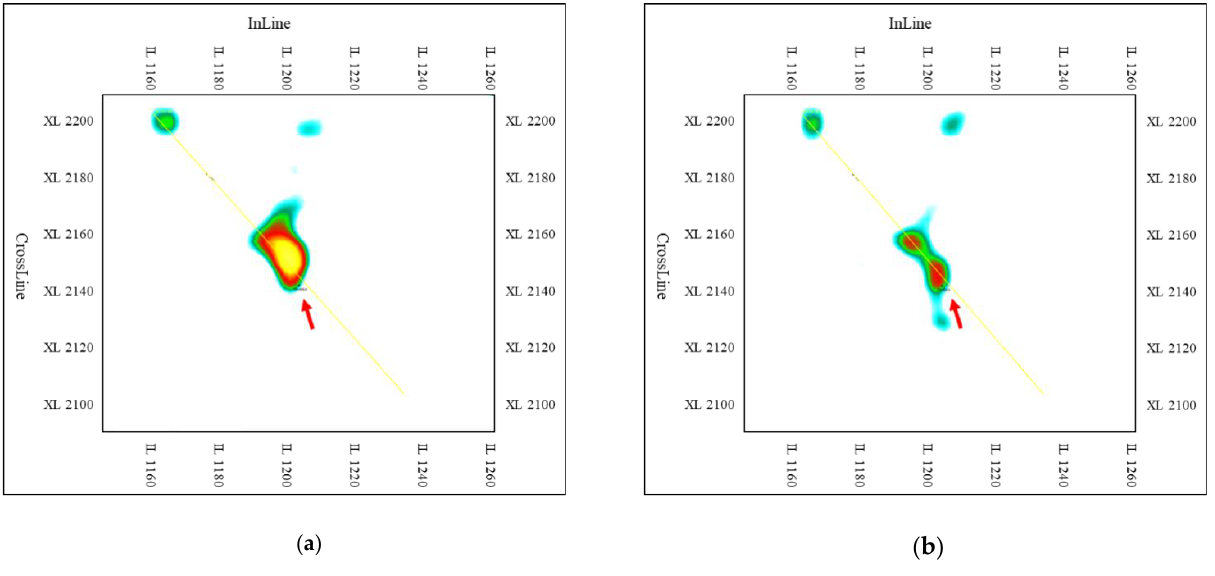
Figure 12. Comparison between results of amplitude attributes. ( a ) zoomed results from RTM; ( b ) zoomed results from LSM. The target caves are corresponding to the ones marked by red arrows in Figure 10.